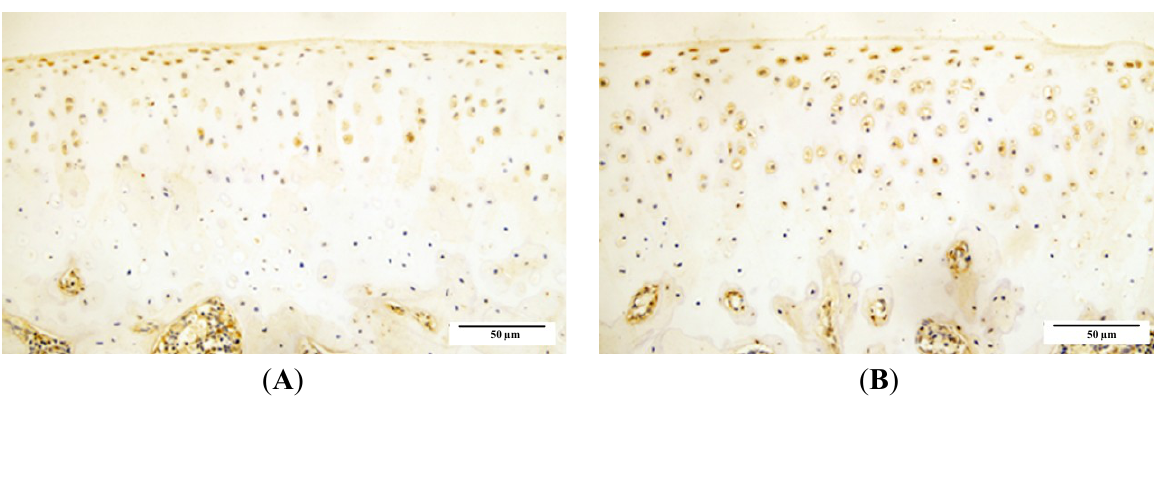
Figure 8. Immunohistochemistry assay for glycosaminoglycans (GAG) in each age group. ( A ) 1-month group; (B ) 3-month group; ( C ) 6-month group; ( D ) 9-month group; and ( E ) 12-month